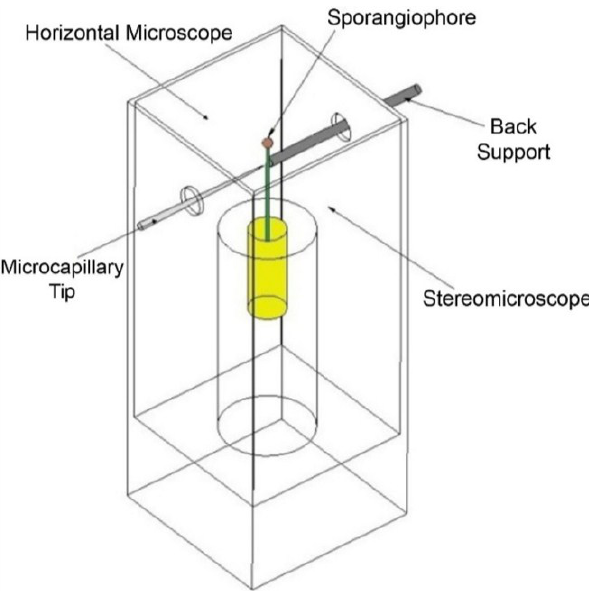
Figure 8. An illustration of the experimental chamber used for anoxia experiments. A vial containing a sporangiophore is inserted into a holder inside the chamber. Afterwards, a back support is advanced manually to the sporangiophore stalk. The back support keeps the